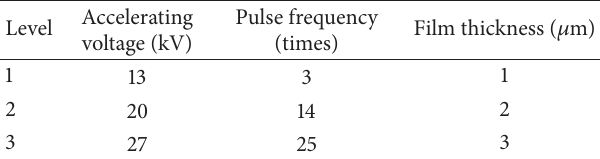
Table 1: The level and factors of orthogonal experiment.